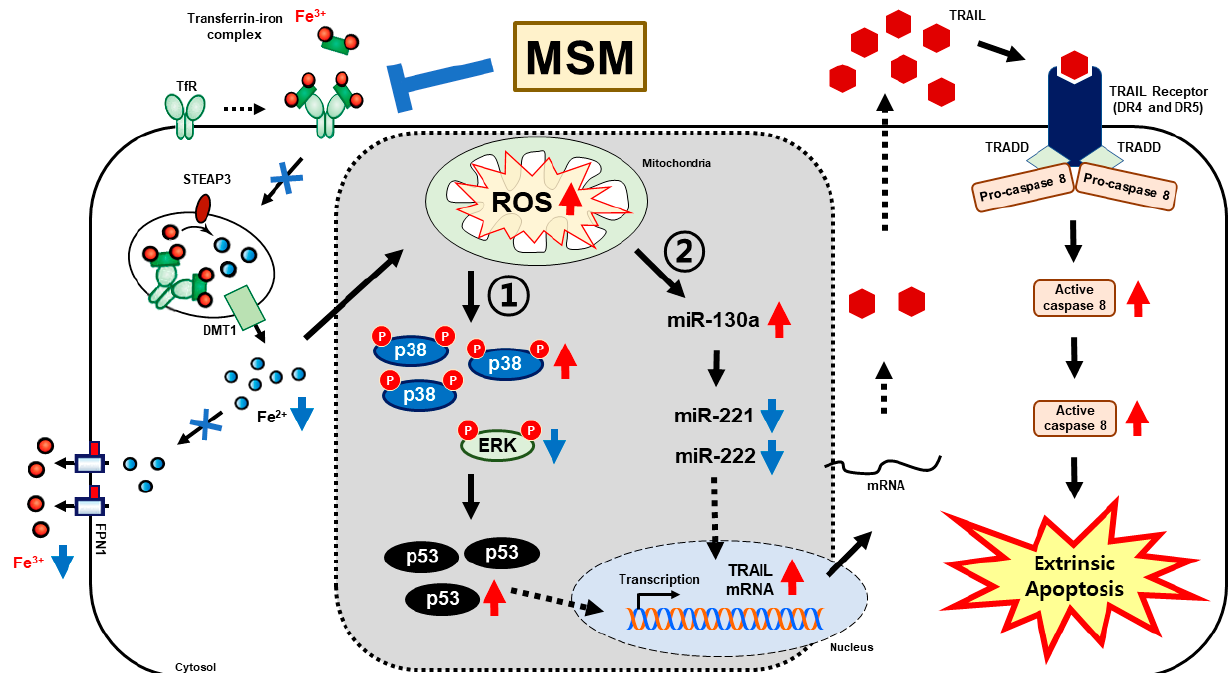
Figure 7. The molecular regulatory mechanism of MSM in the induction of TRAIL-mediated extrinsic apoptosis. MSM inhibited iron metabolism to generate ROS formation, regulating p38/ERK/p53 signaling to induce TRAIL expression. Moreover, MSM enhanced TRAIL expression by upregulating miR-130a and downregulating miR-221 and miR-222 ex- pressions.